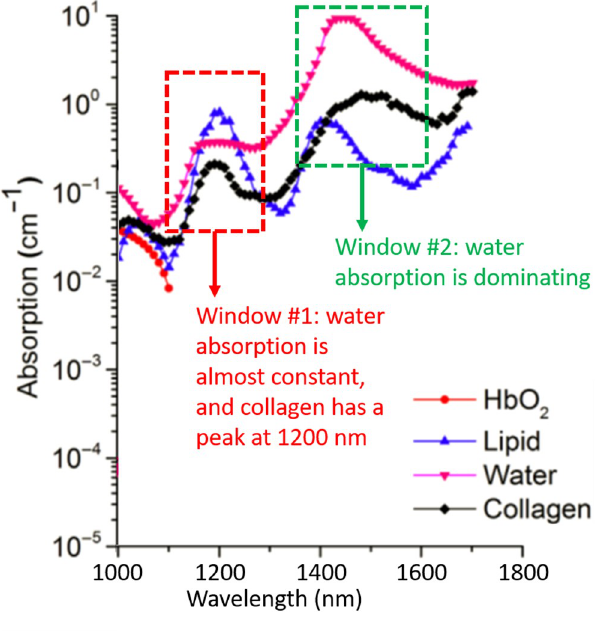
Fig 1. Optical absorptions of oxyhemoglobin, lipid, collagen, and water. In the collagen dominating (window #1), water has nearly constant absorption and, by contrast, collagen peaks around 1200 nm. In the water dominating (window #2), water peaks about 1470 nm, and collagen peaks around 1520 and 1540 nm (figure adopted from [61]).